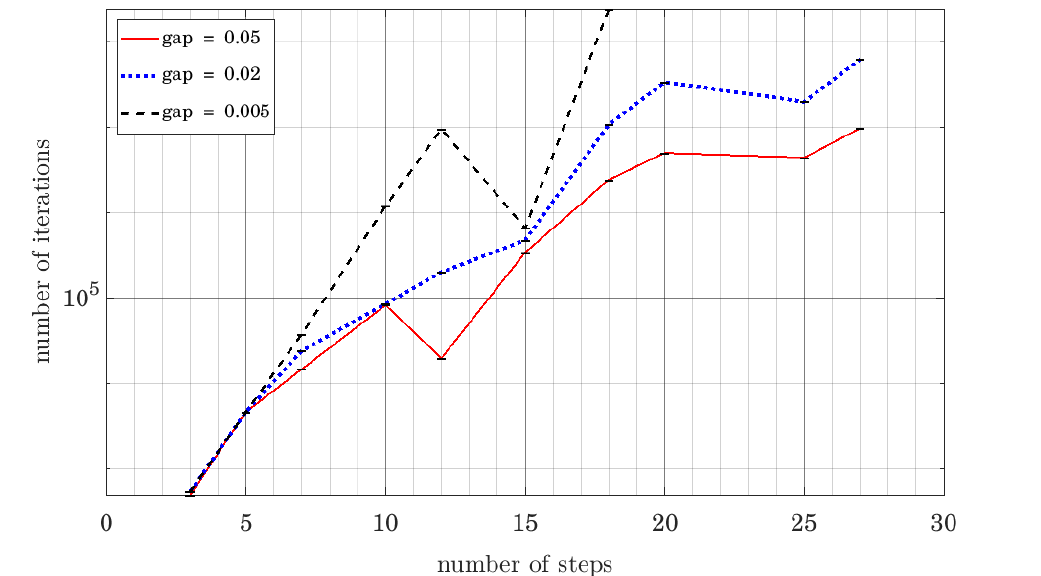
Figure 5. Number of iterations as a function of the number of steps, calculated for Gurobi gap values 0.05, 0.02 and 0.005; vertical axis is given in logarithmic